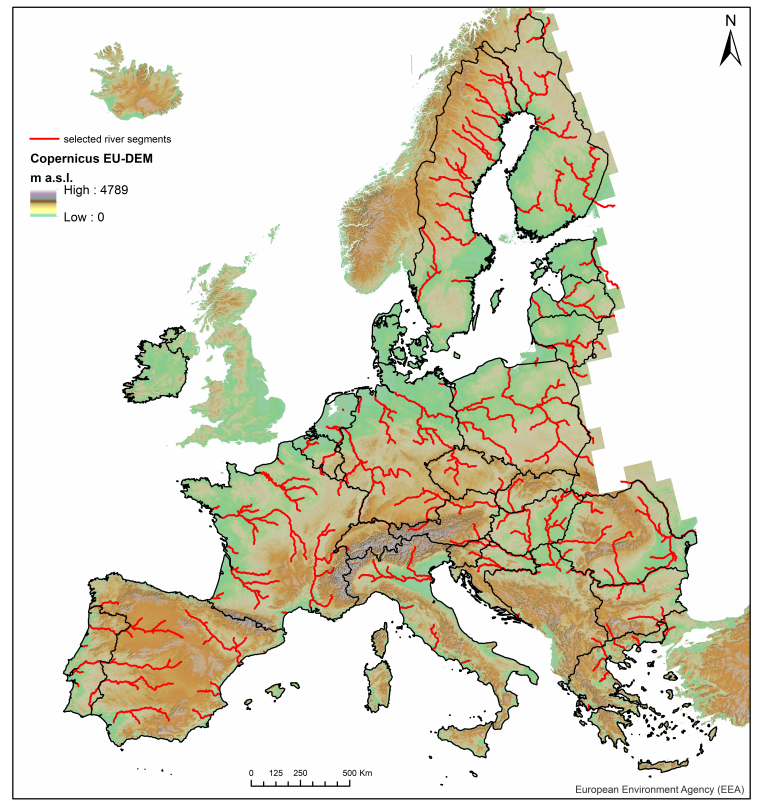
Figure 2. The Digital Elevation Model over Europe (EU-DEM) (25-m resolution) and the selected river segments analyzed in this work